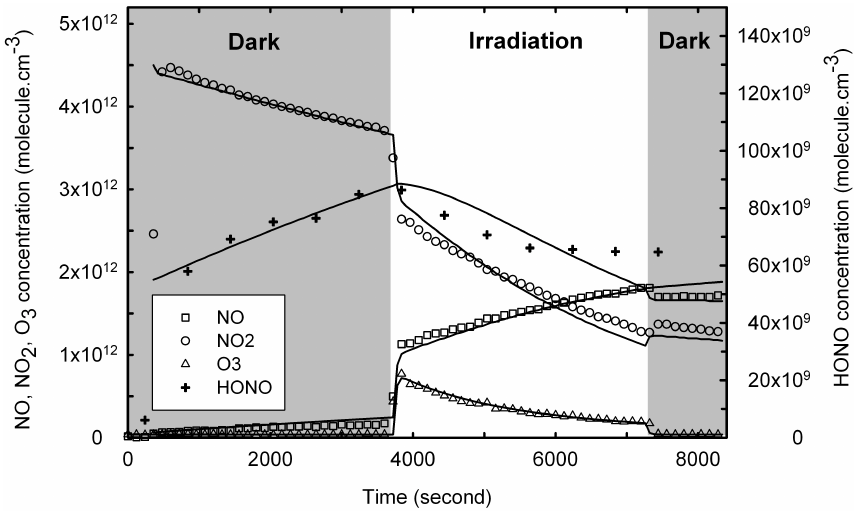
Fig. 6. NO x /air/light system investigation in the CESAM chamber: comparison of simulated (solid lines) and experimental concentrations (symbols) of NO, NO 2 , ozone and HONO as a function of